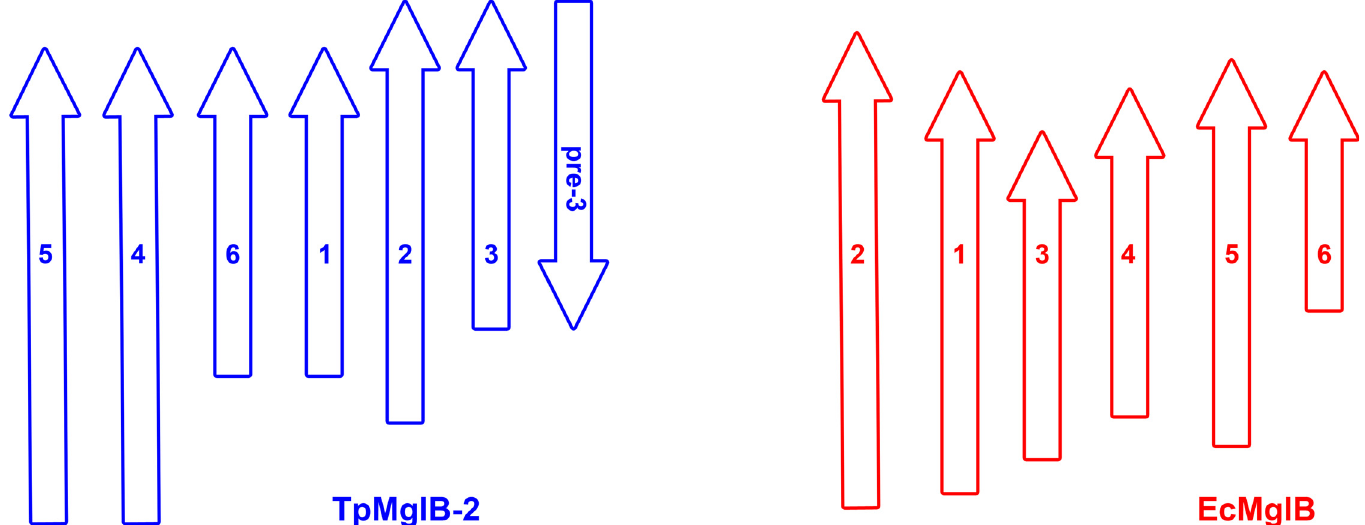
Fig 3. Comparison of the topologies of the central β -sheets in the N-lobes of TpMglB-2 and EcMglB. The β -strands for the respective sheets are drawn as arrows, with those from TpMglB-2 shown in blue and those from EcMglB in red. The strands are numbered according to the orders in which they appear in the primary structures of their respective proteins. The positions and sizes of the strands are approximately to scale. The antiparallel strand in TpMglB-2 was not assigned its own number in this scheme because it does not correspond to any strand in EcMglB. Its designation, “ pre-3 ” , indicates that it immediately precedes strand 3 in the primary structure of